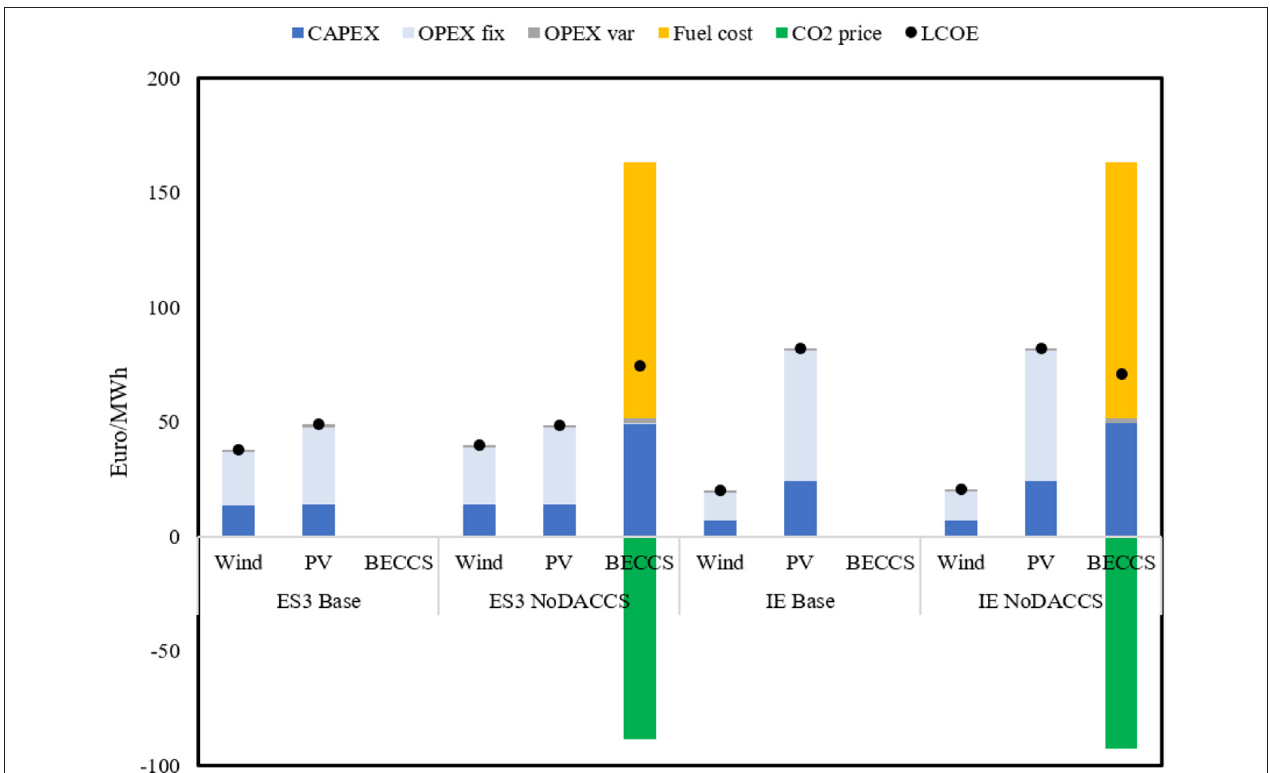
FIGURE 5 | LCOE calculated for onshore wind power, solar PV and BECCS for the regions ES3 (sunny) and IE (windy) for the Base case and the NoDACCS case respectively.